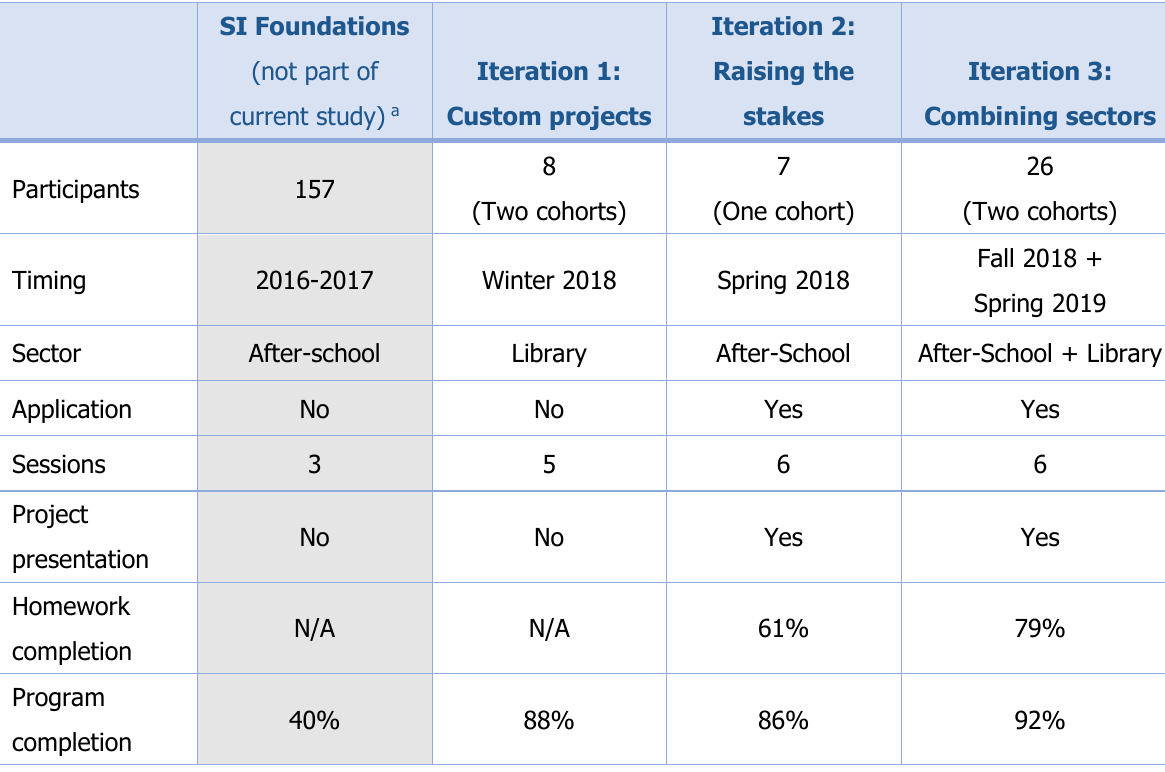
Table 1. SI Foundations and SI Leadership Program